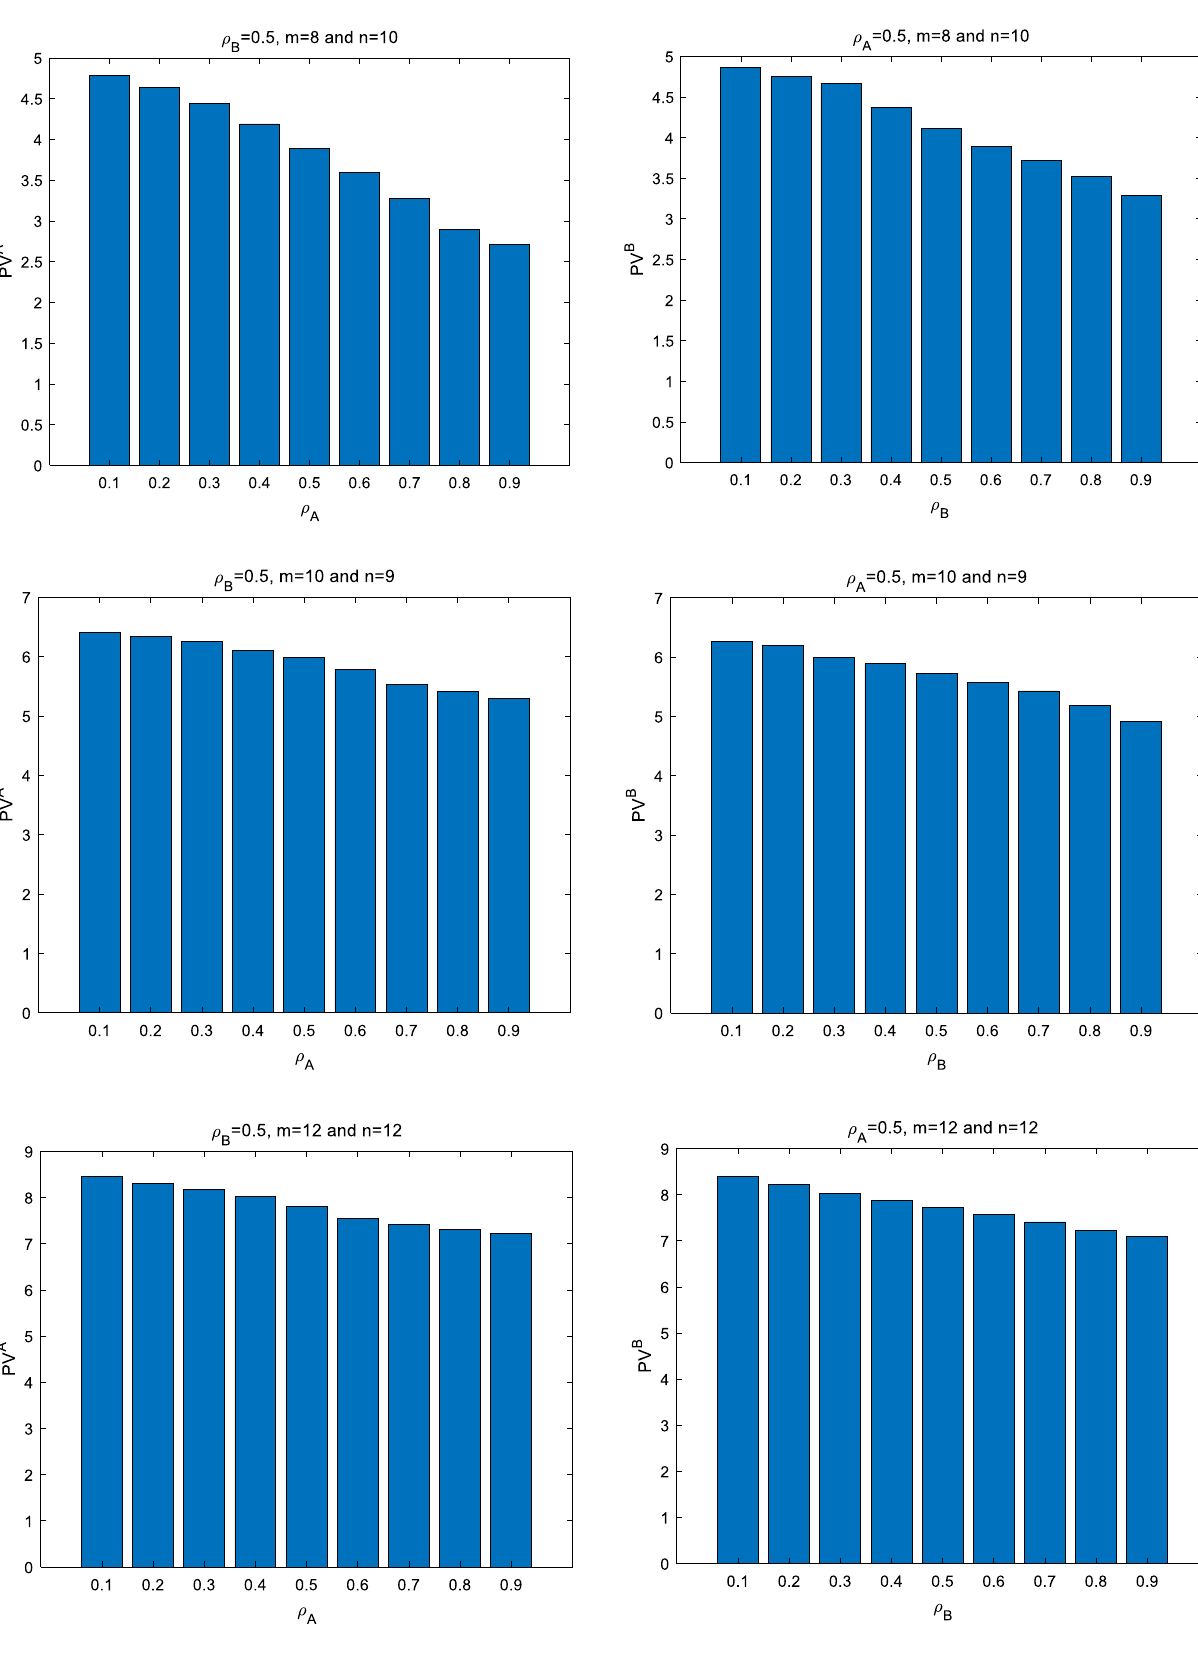
Fig. 2 The average values of PV A and PV B under different values of m , n , 𝜌 A , and 𝜌